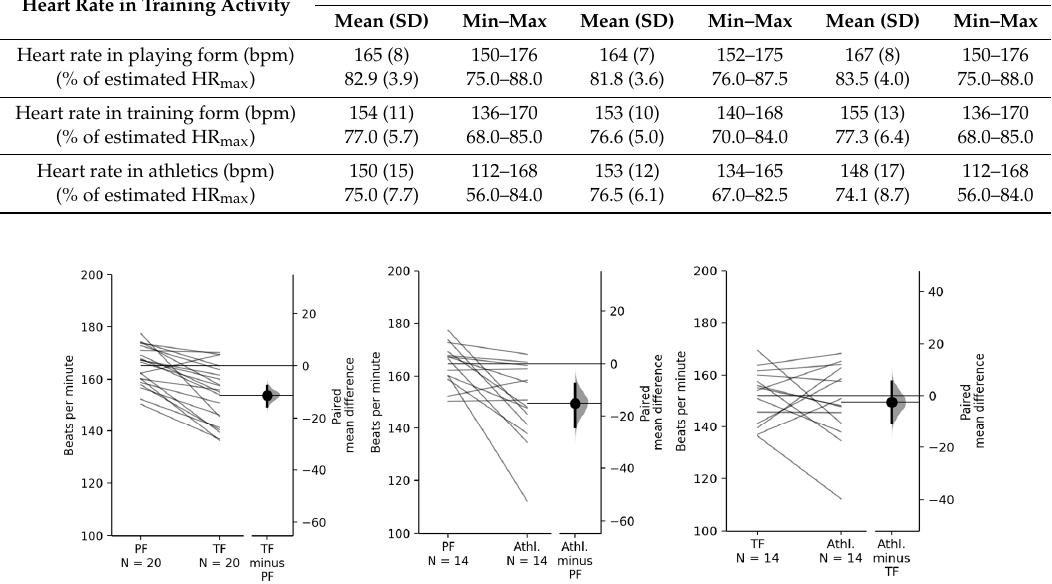
Figure 3. Mean heart rates of each team for different training activities. (PF = playing form; TF = training form; Athl. = athletic. N = 14 teams for the comparison regarding the athletic part, as 6 teams did not perform athletic exercises).